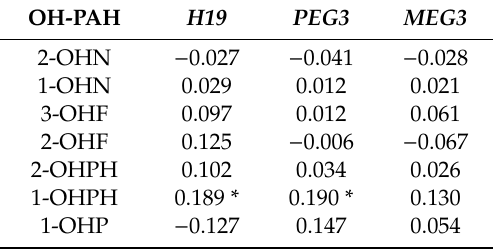
Table 4. The correlation coe ffi cients of OH-PAHs and the average methylation levels of imprinting genes. OH-PAH H19 PEG3